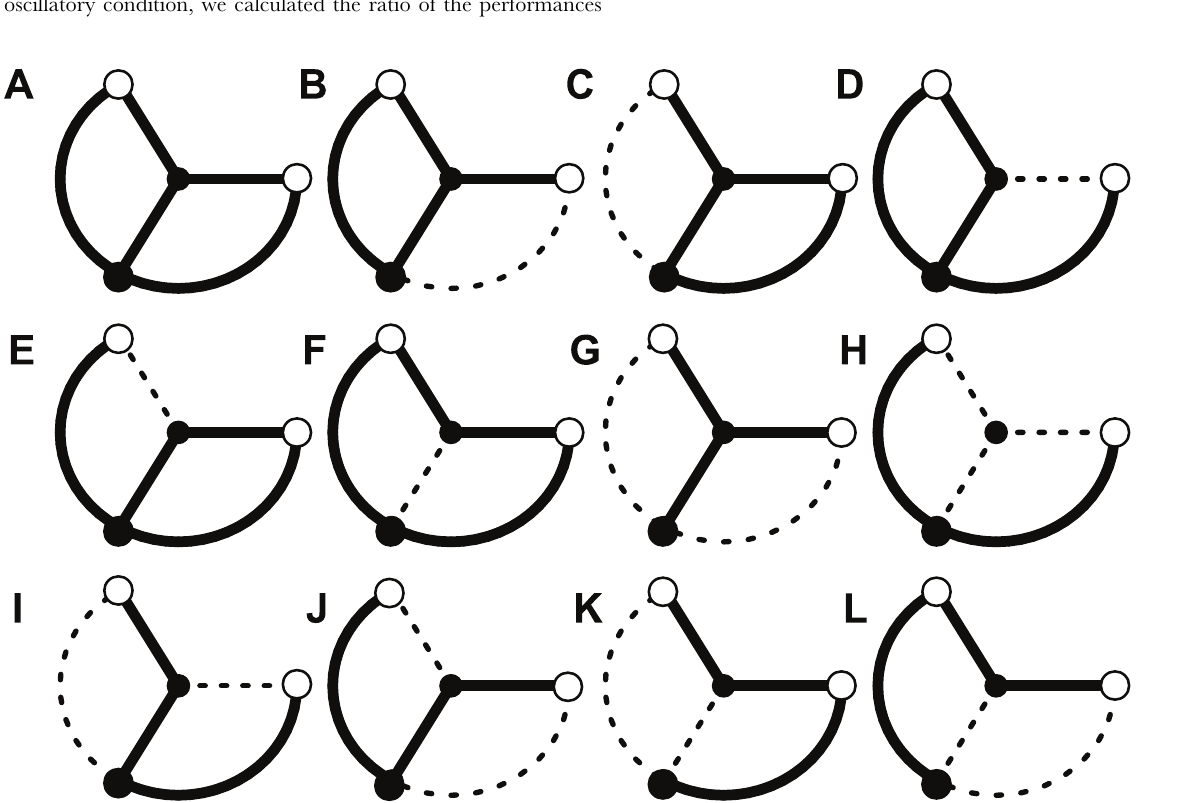
Figure 8. Twelve equilibria for the network in Fig. 7 represented in network-topology form. A Complete mesh, B–F partial mesh, G Y- shaped network, H–J V-shaped network, K and L the others.